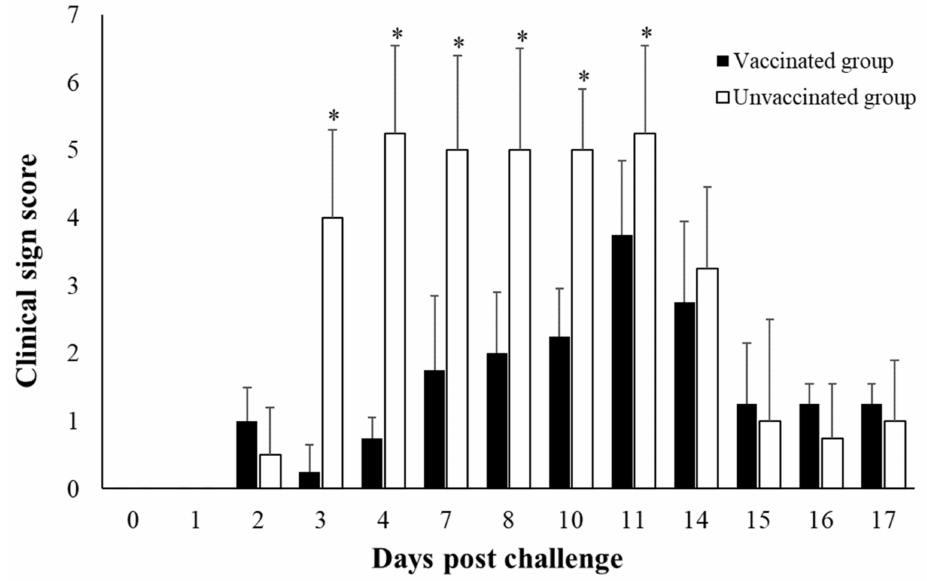
Figure 1. Clinical sign score. *, statistically significance. p <